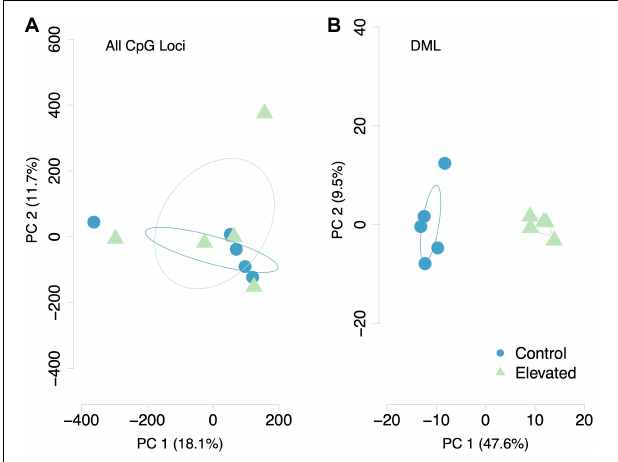
FIGURE 4 | Principal Components Analysis of (A) all CpG loci with 5x coverage across samples and (B) DML. Methylation status of individual CpG loci explained 29.2% of variation between samples when considering all CpG loci. Methylation status of DML explained 57.1% of sample